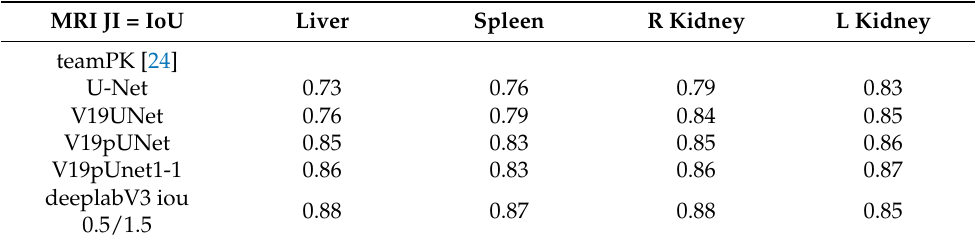
Table 7. Comparing to IoU of related approaches (CHAOS dataset).